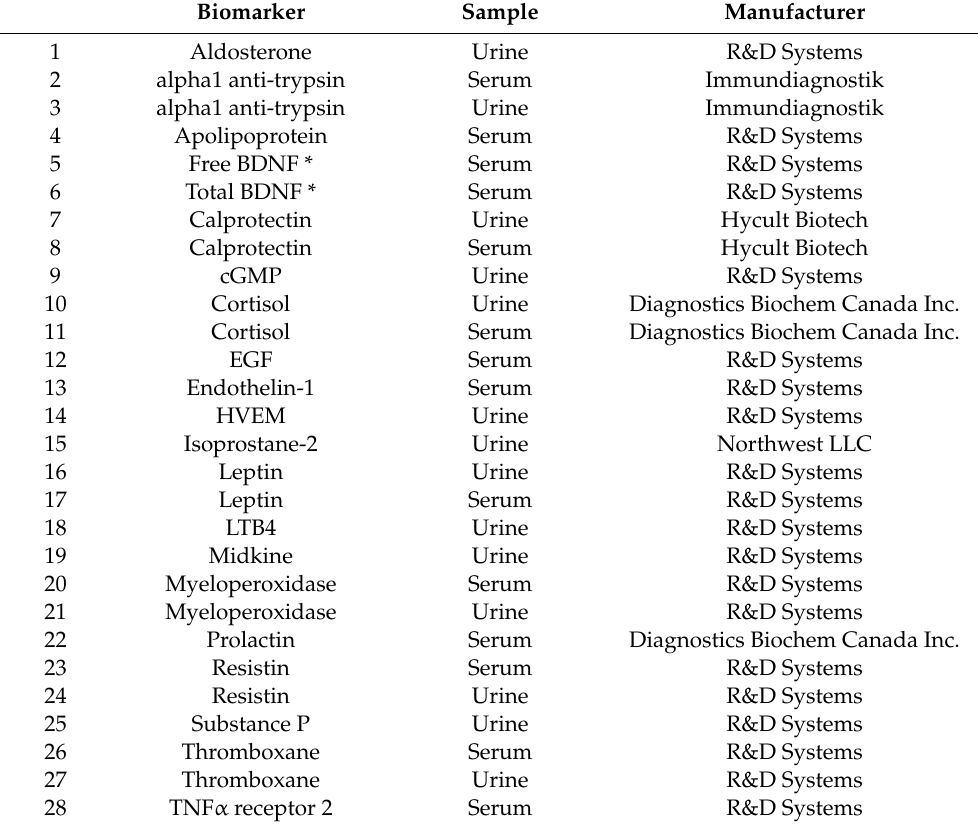
Table 6. Biomarkers tested, the sample origin and manufacturer of the commercially available assay.